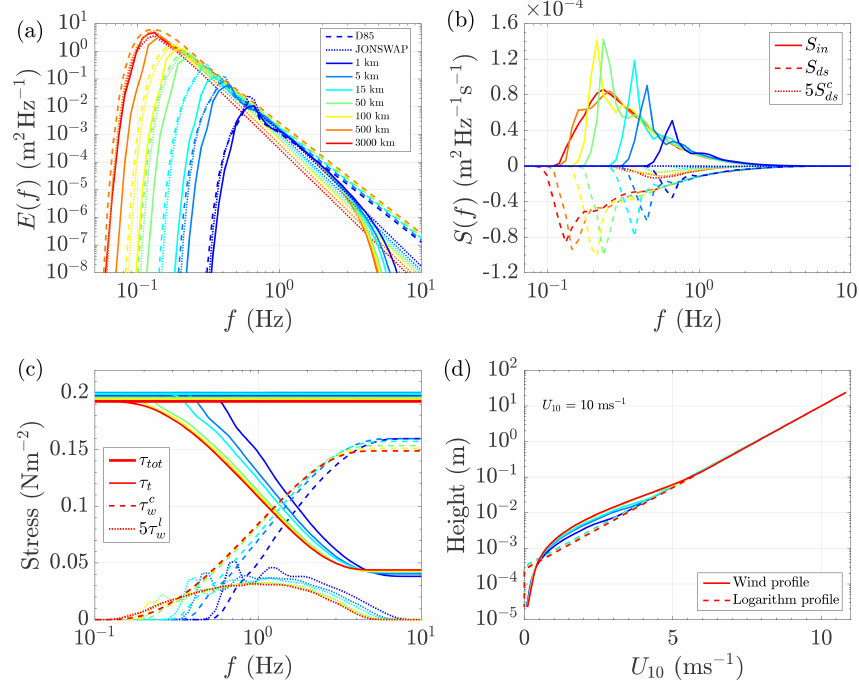
Figure 3. Wave spectrum (a) , wind-input and dissipation source terms (b) , stress distribution over frequencies (c) , and wind profile (d) calculated from WBLM, in 10ms − 1 wind speed conditions at different fetches after 72h simulation, in the fetch-limited wave growth study. The dashed lines and dotted lines in panel (a) are the wave spectrum parameterization from D85 (Donelan et al., 1985) and JONSWAP (Hasselmann et al., 1973); the solid lines are from WBLM. The solid, dashed, and dotted lines in panel (b) are the WBLM wind-input ( S in ), white-capping dissipation ( S ds ), and 5 times the cumulative dissipation (5 S c ) source functions, respectively. Thick solid, thin solid, dashed, ds and dotted lines in panel (c) are the total stress ( τ tot ), turbulent stress ( τ t ), cumulative wave-induced stress ( τ c w ), and 5 times the local wave- induced stress (5 τ l w ) from WBLM. The solid lines in panel (d) are calculated from WBLM, and the dashed lines are the relative logarithm wind profiles extended from wind speed at 10m